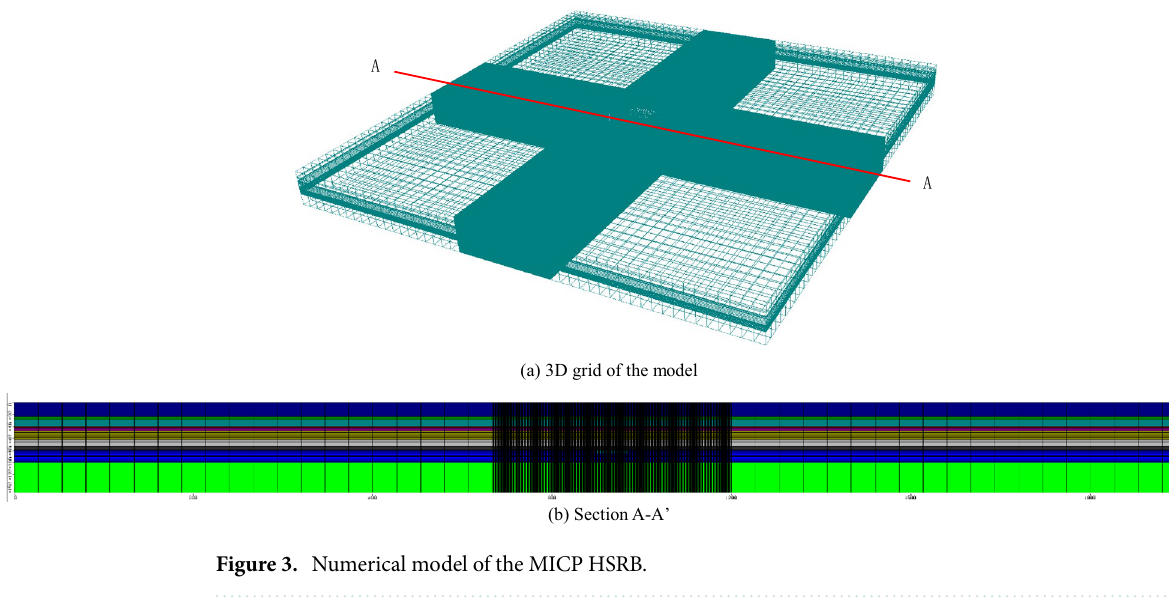
Figure 3. Numerical model of the MICP HSRB.